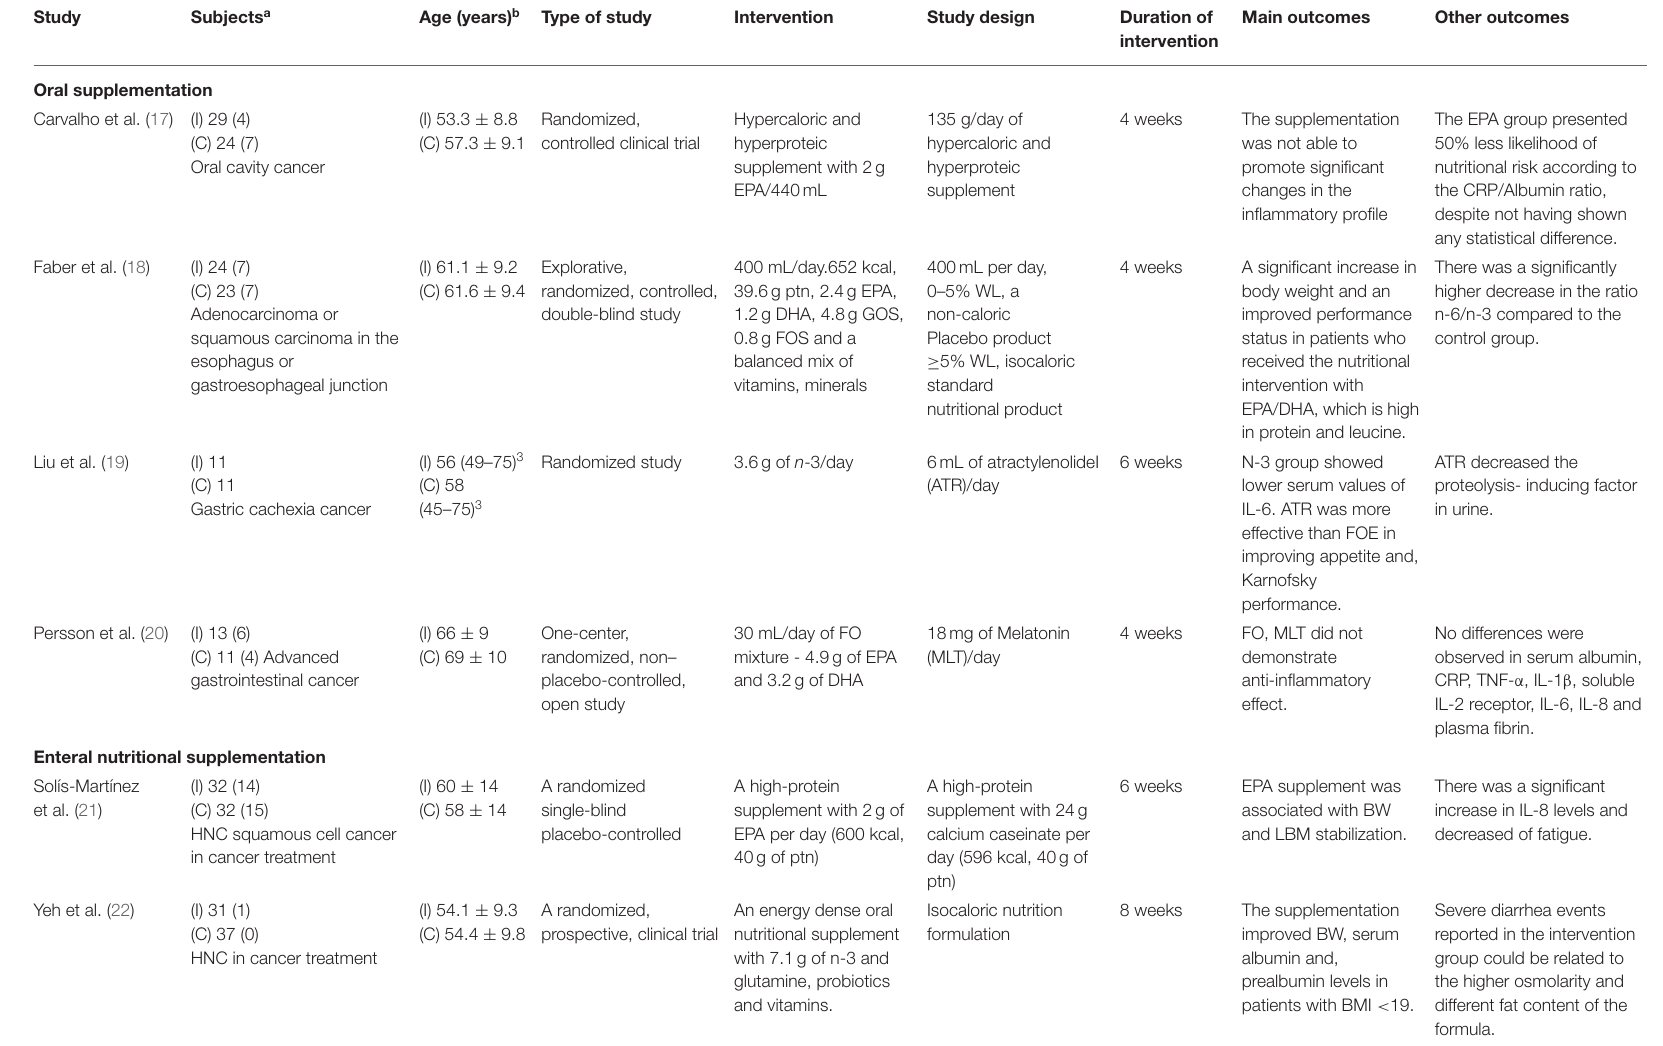
TABLE 2 | Main characteristics of the studies included in the